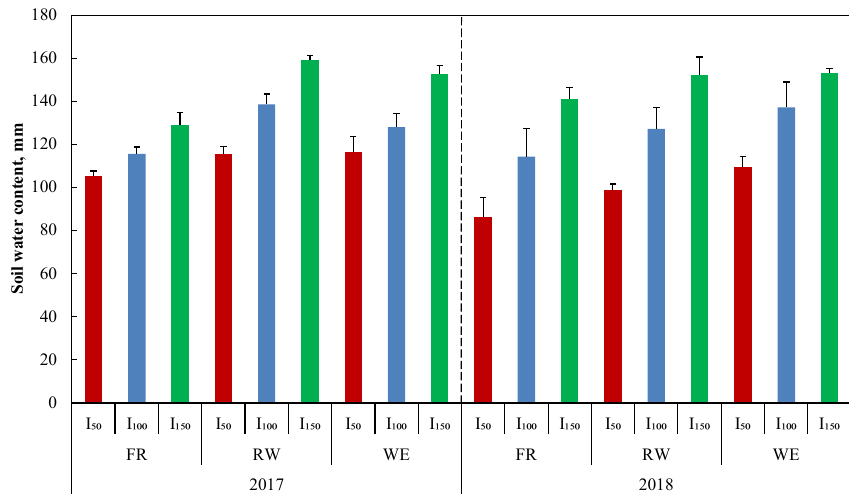
Figure 3. Water content in the soil profile (0–100 cm deep) at three irrigation levels (I 50 , I 100 , and I 150 : 50%, 100%, and 150% crop evapotranspiration, respectively) across three water qualities (FR: freshwater, RW: reclaimed wastewater, and WE: well-water) measured at three dates in both experimental years. Bars represent mean values ± standard error of triplicate measurements.